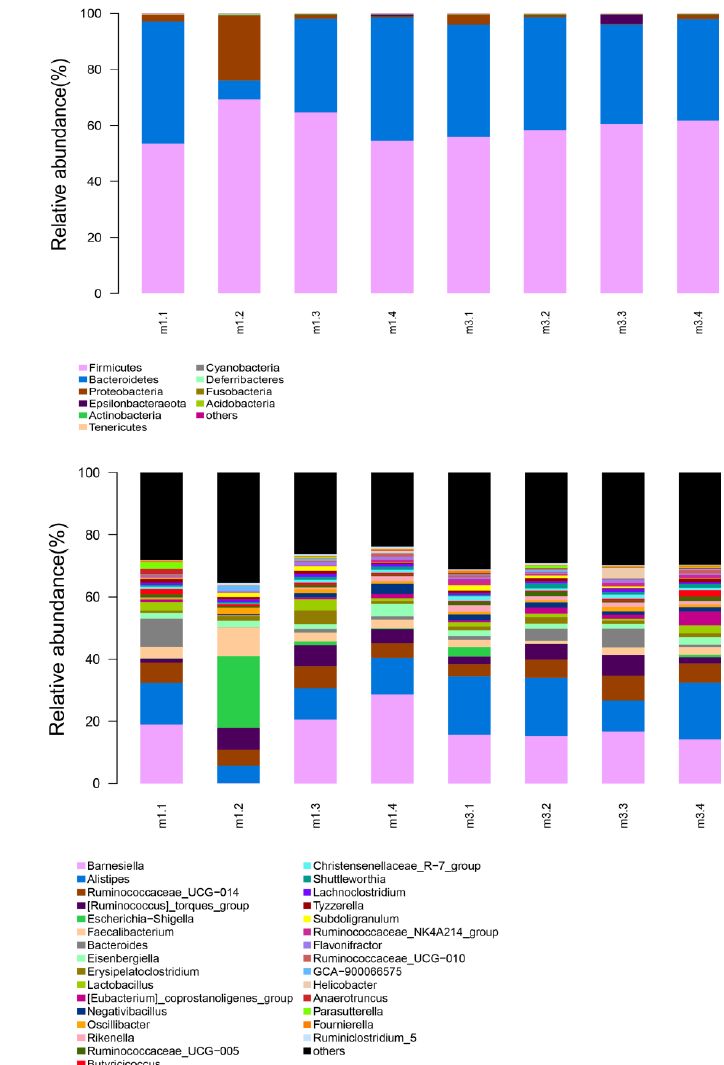
Figure 2. The gut microbiota composition is shown at the phylum level ( A ) and genus level ( B ). m1, control. m3, E. faecium .